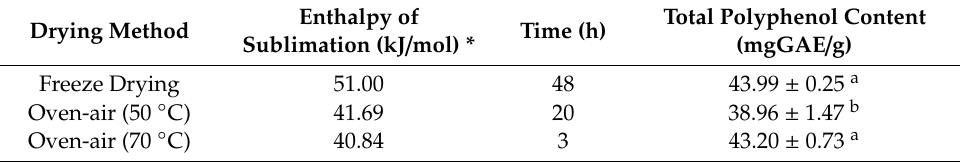
Table 1. E ff ect of drying process on total polyphenol amount in cocoa beans.